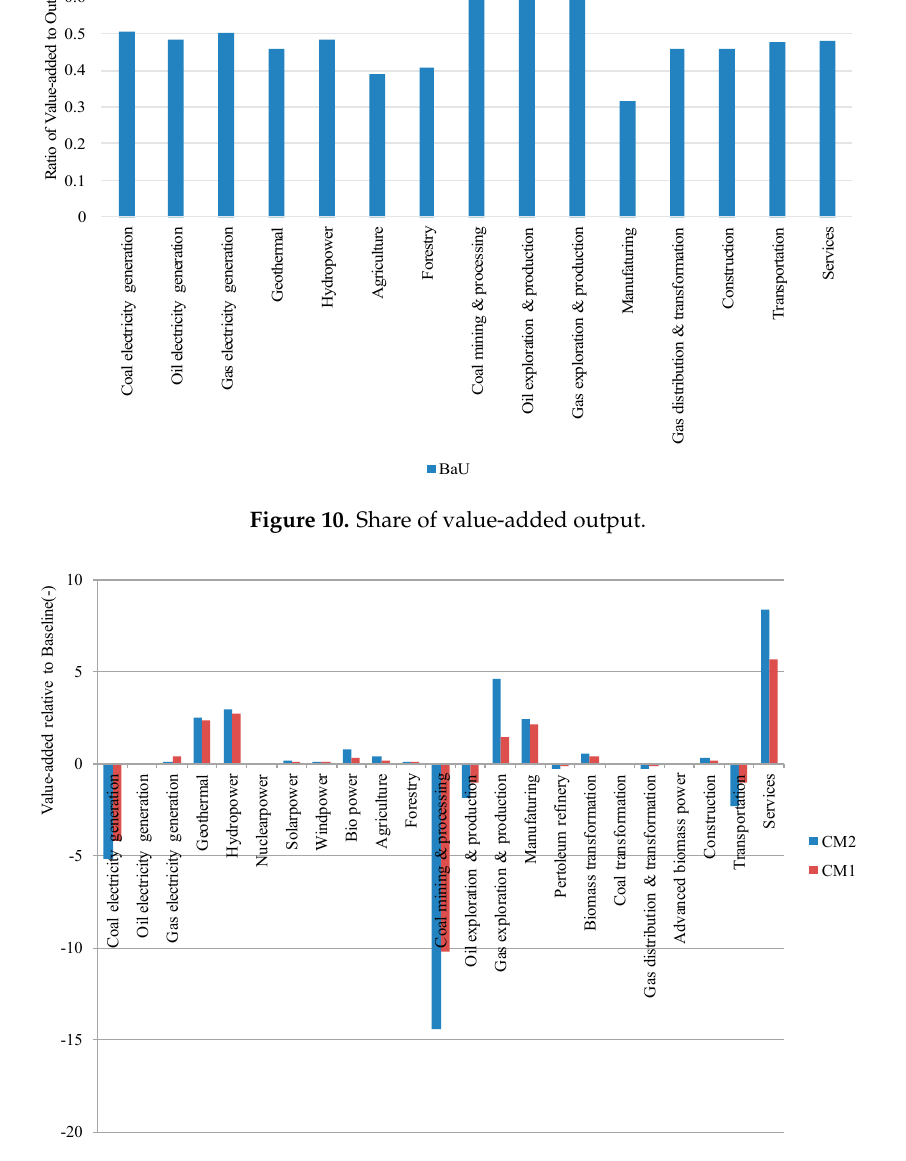
Figure 11. Sector-wise value-added output in 2030 relative to the baseline year.